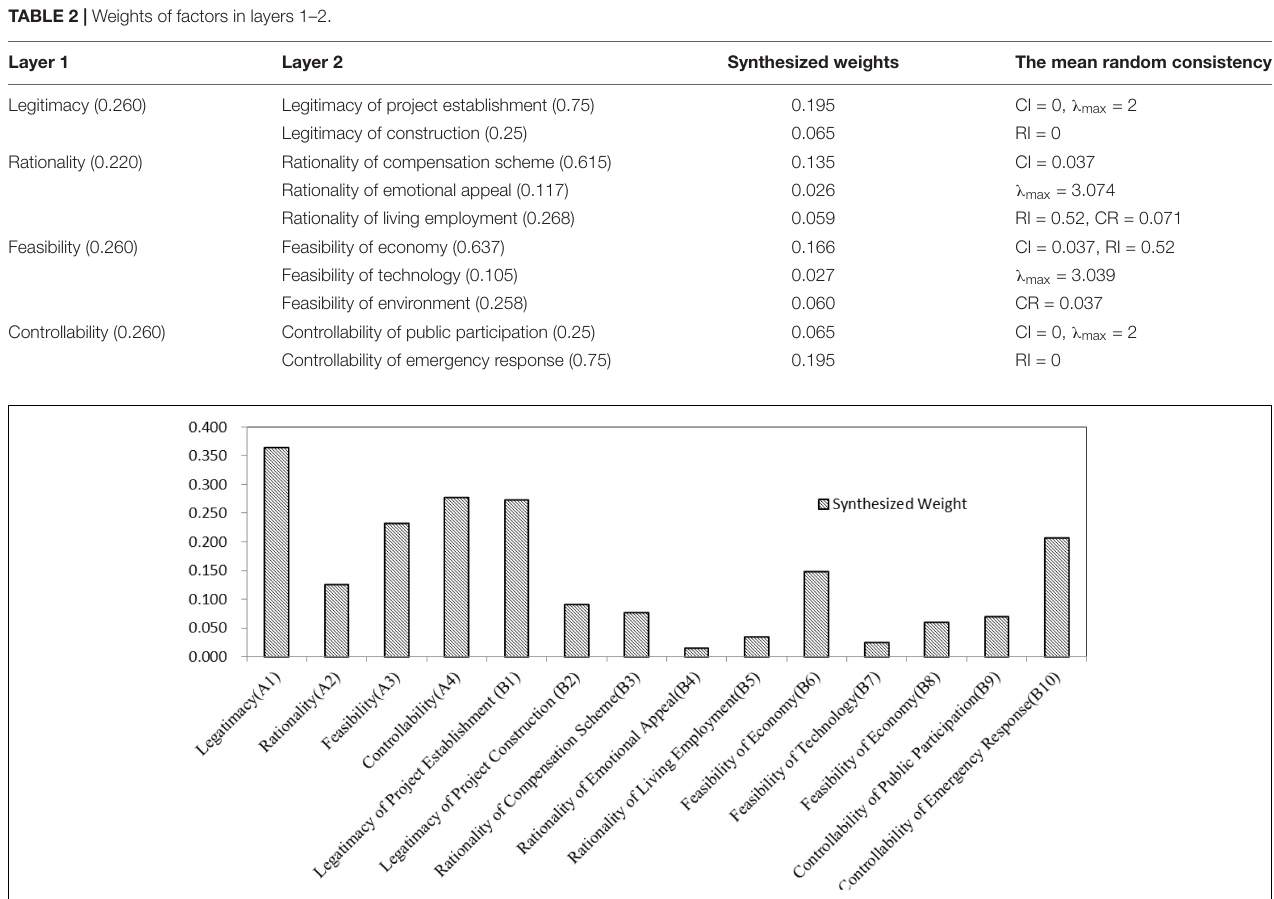
FIGURE 6 | Synthesized weights for ranking risks in conflicts of land expropriation.